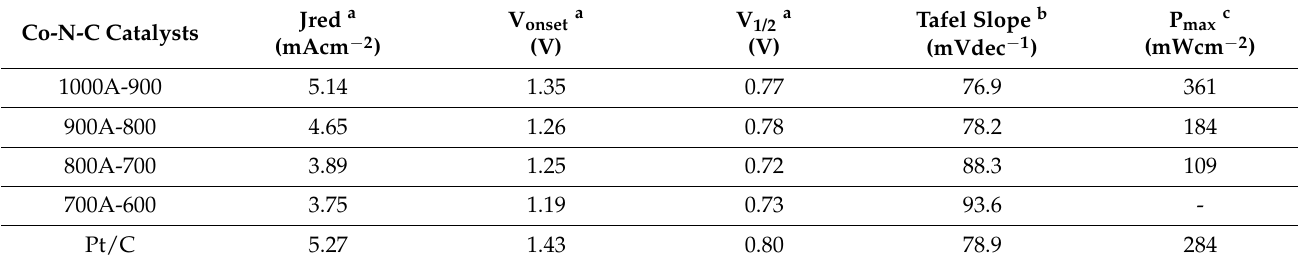
a : obtained from LSV curves in Figure 9a. b : obtained from curves in Figure 9b. c : obtained from curves in Figure 10.